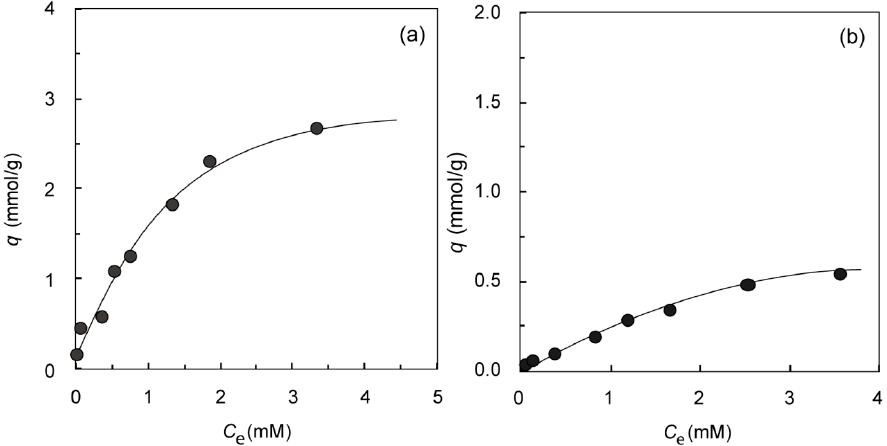
Figure 7. Adsorption isotherms of Ag(I) on PEI-MAR from: ( a ) 0.1 M nitric acid, and ( b ) a mixture of 50 mM sulfuric acid and 50 mM thiourea. Conditions: weight of adsorbent = 10 mg, volume of test solution = 10 mL, temperature = 30 °C, and shaking time = 4 days.